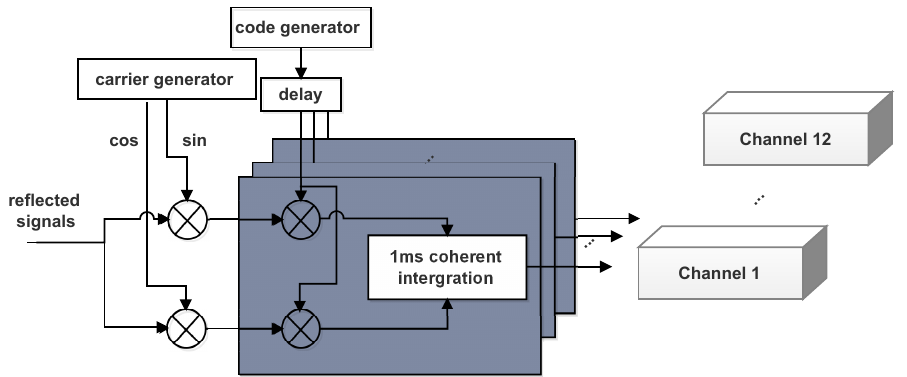
Figure 6. Channel structure of the reflection channels.